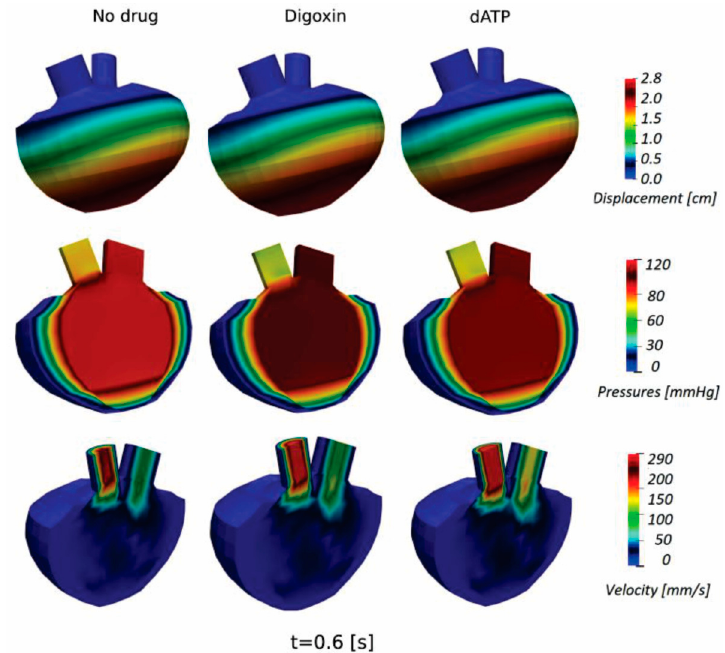
Figure 17. Displacement, pressures, and velocity distribution (peak systole, t = 0.6 s) for DCM at basic condition (without administered drug) and with using Digoxin and dATP.